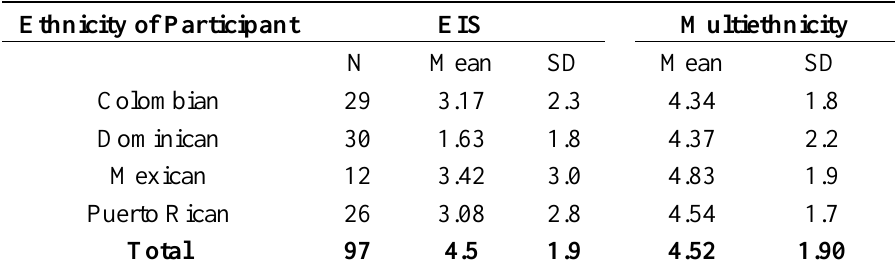
Table 3. Mean number of ethnic identifications and EIS by ethnicity.